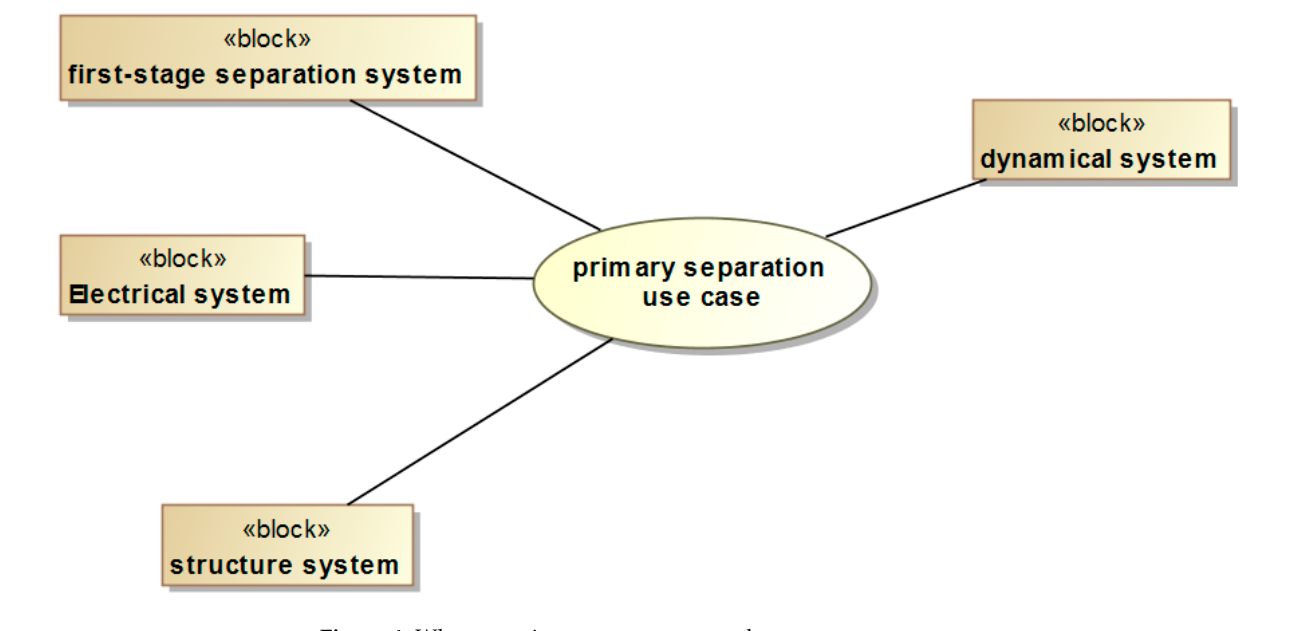
Figure 4. Where requirements are proposed.